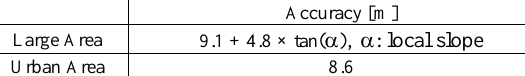
Table 4. Accuracy of TSX DEM against reference DTM